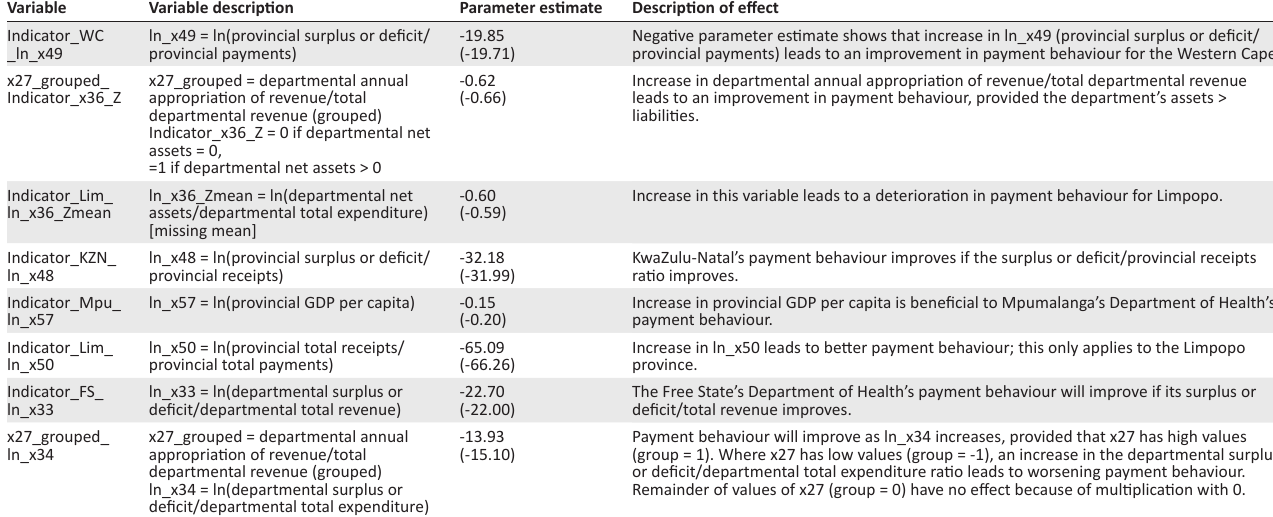
TABLE 5: Details of the Advanced Models (Health Advanced Model 1 [Model 2]), specifically developed for the Department of Health. Variable Variable